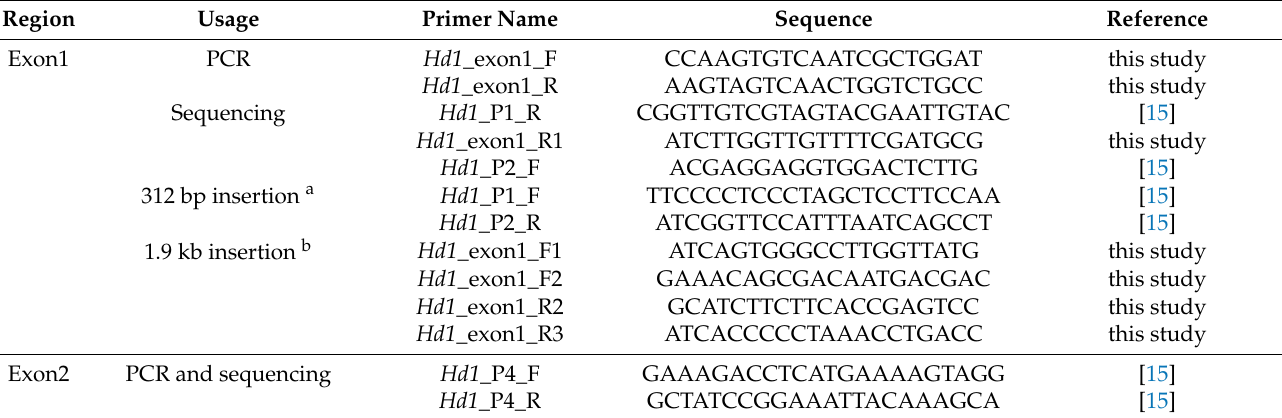
Table 4. PCR and sequencing primers used for Hd1